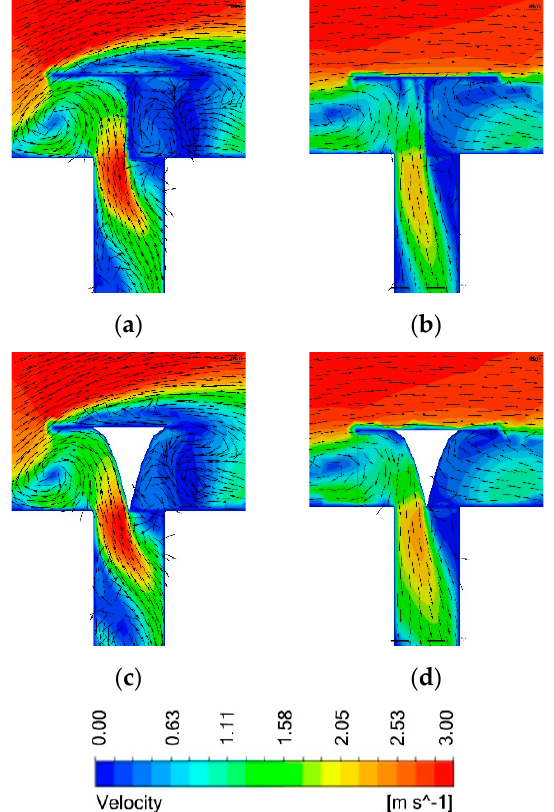
Figure 14. Representation of flow fields around the wind catcher shape variations by velocity color maps and normalized tangentially projected vector fields on the vertical section: ‘empty’ + 1 m deflector—( a ) cross and ( b ) longitudinal; ‘parabola + 1 m’ ( c ) cross and ( d ) longitudinal direction.